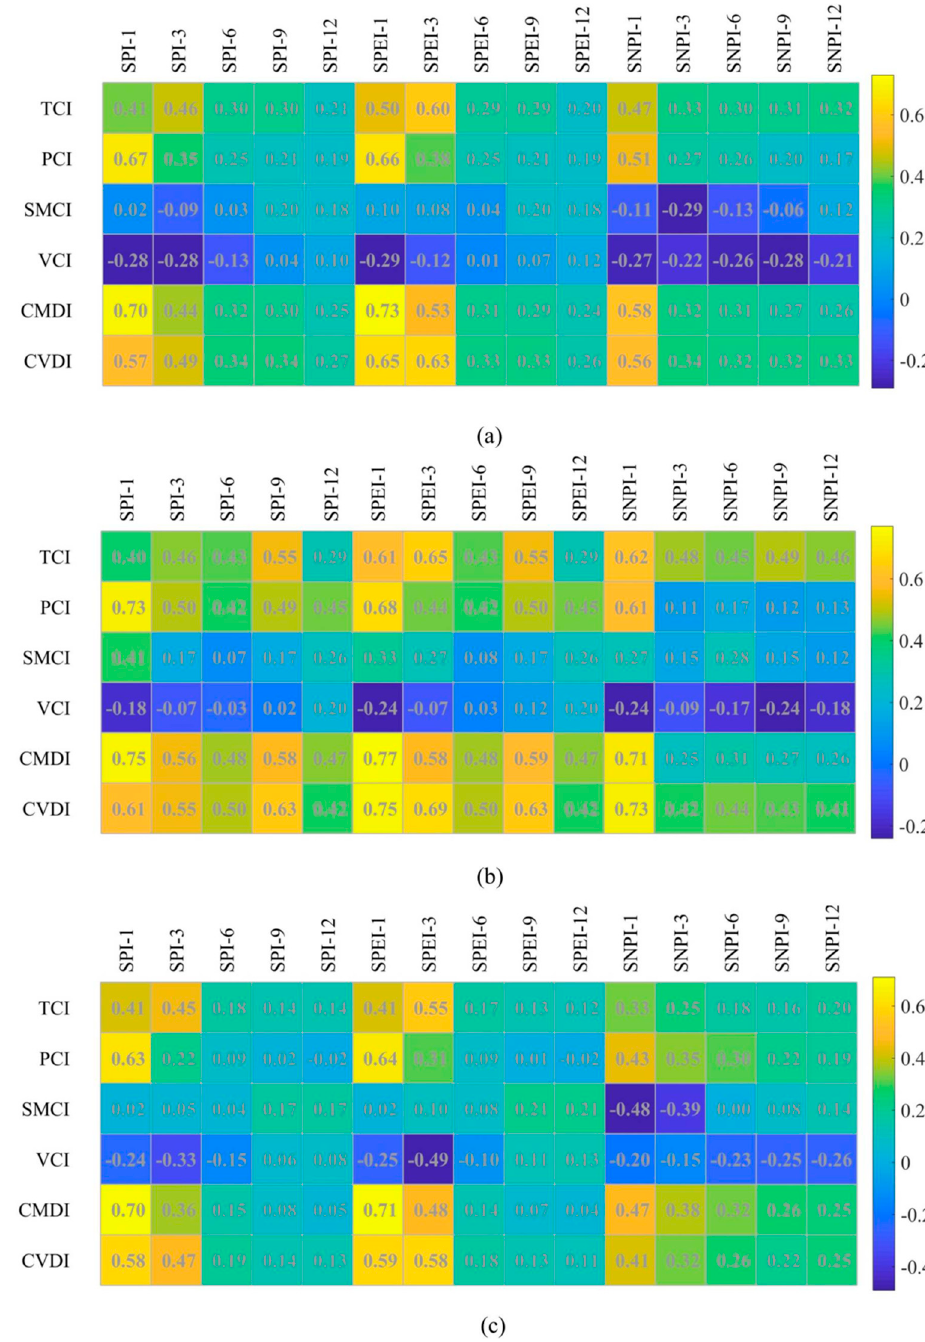
Figure 5. Correlation coefficients (r) between CI-based drought indices (columns) and in situ drought indices (rows) ( a ) monthly correlations, ( b ) monthly correlations in the growing season, ( c ) monthly correlations in non-growing season.